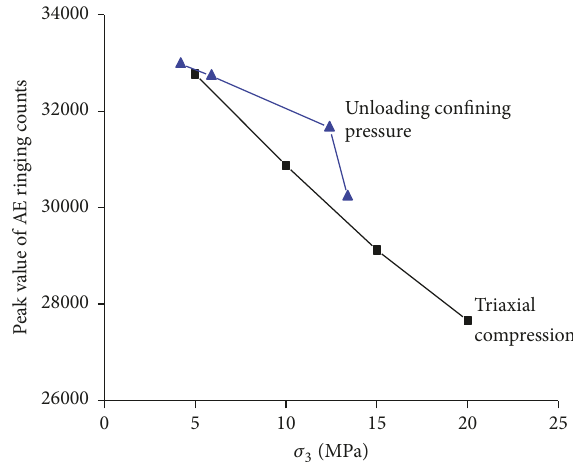
Figure 10: Peak value of AE ringing counts under different stress